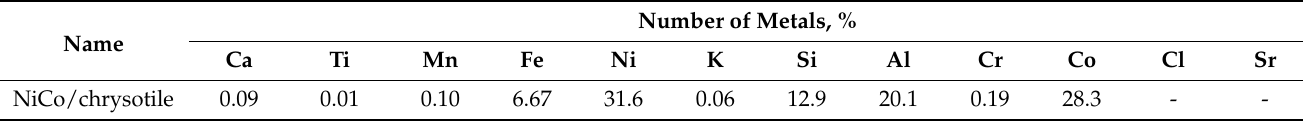
Table 1. Elemental chemical composition of the nanocatalyst.